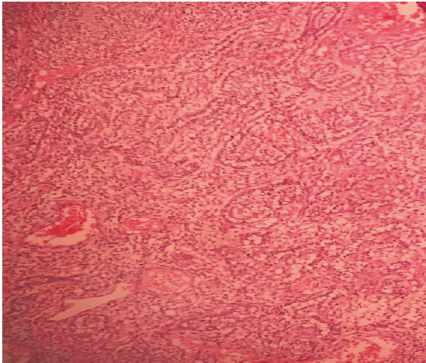
Figure 2: Hematoxylin-eosin (HE) staining, magnification 400x, clear cell cords resembling Sertoli cells.